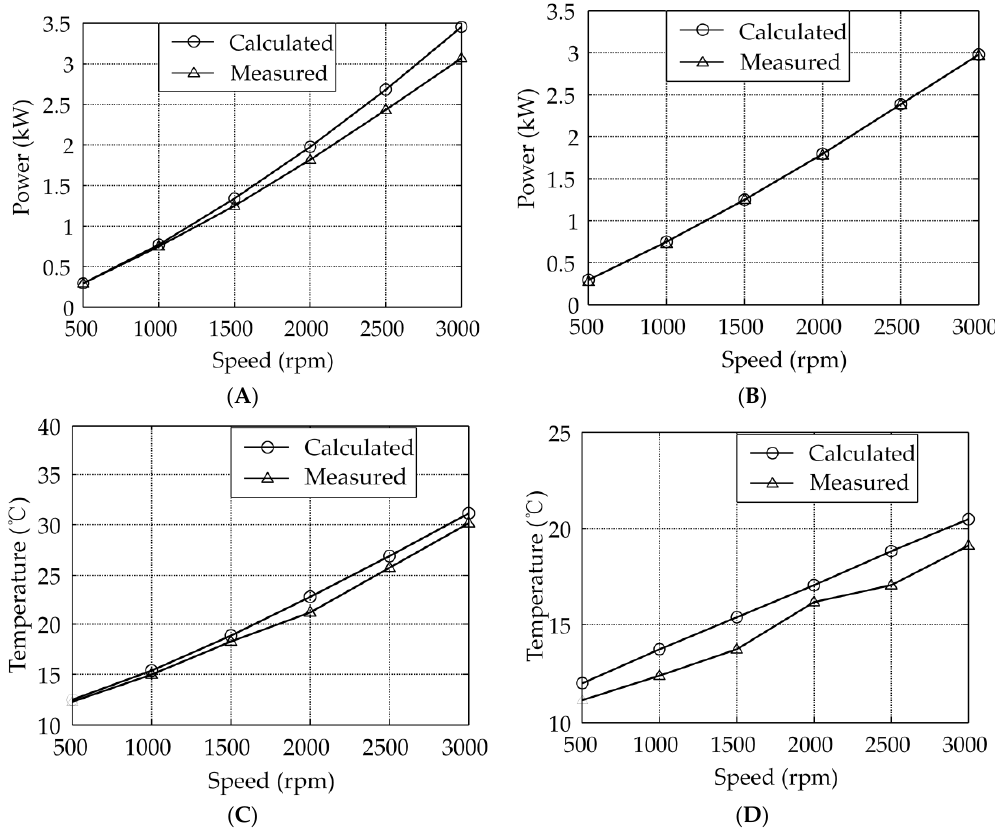
Figure 22. Comparison of the measured and calculated values of the prototype when flow speed is 0.8 m/s: ( A ) initial thermal power; ( B ) actual thermal power; ( C ) temperature of point A; ( D ) temperature of point B.